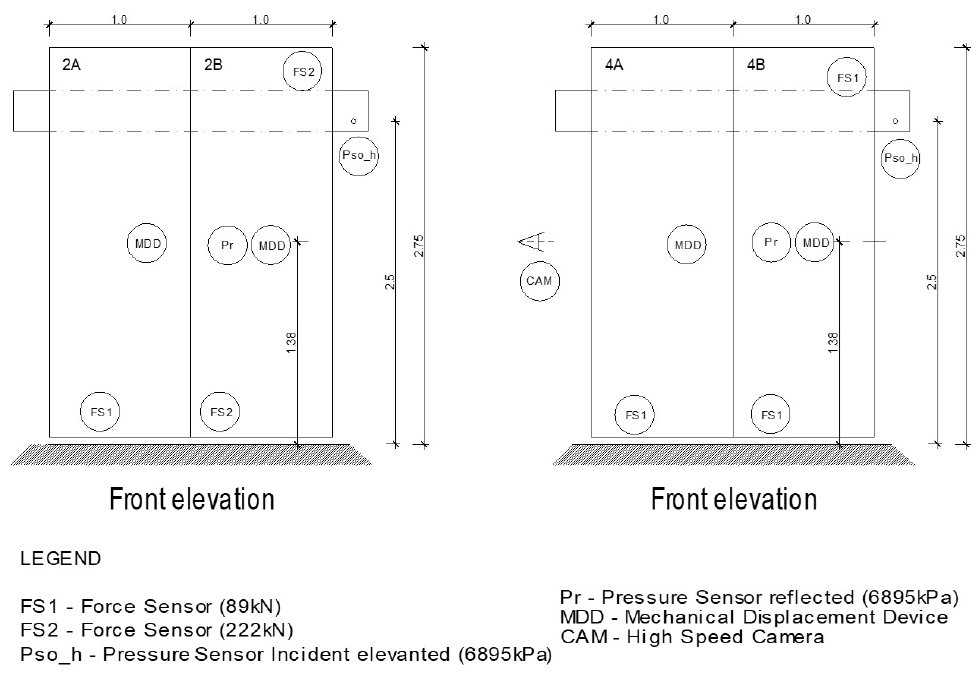
Figure 7. Sensors placement.